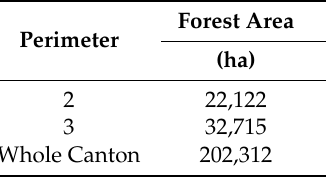
Figure 10. Extract of the harvesting system map (region near Schiers in canton of Grisons). Table 6. Road Densities for the observed perimeters. The road densities were split into a class of roads with a weight limit between 18 and 27 t, 28 and 40 t and an overall class between 18 and 40